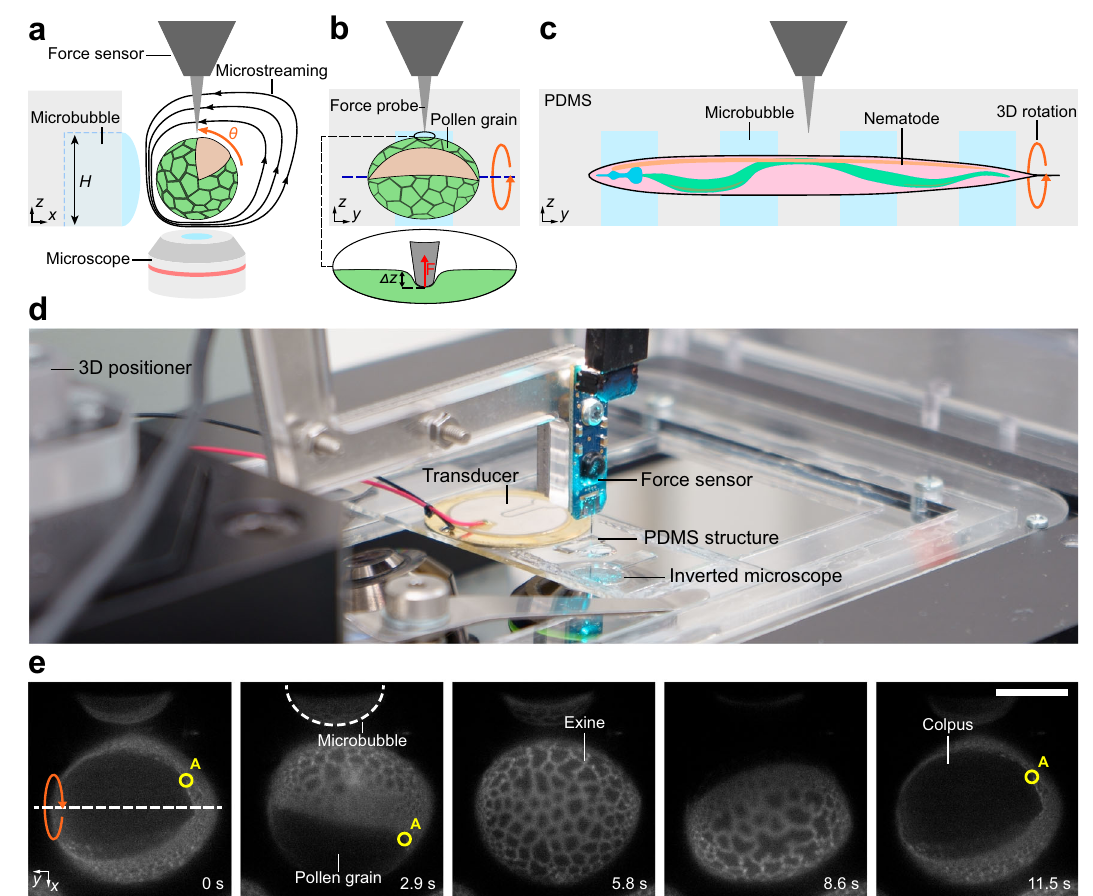
Fig. 1 Setup for acoustic manipulation and micro-indentation. a , b Side and front view schematics describing the 3D characterization of a pollen grain. Acoustic streaming, generated by exciting trapped microbubbles, allows the trapping of pollen grains and their re-orientation with respect to the force sensor. This enables the 3D mechanical characterization of a sample. H denotes the height of the microbubble, θ the rotational angle of the specimen, and x , y , z de fi ne the coordinate system where the force F applied by the sensor in z -direction leads to a displacement Δ z . c A schematic showing the manipulation and indentation of a single C. elegans nematode. By exciting multiple parallel microbubbles, the same design used for pollen grains can be applied to manipulate a nematode. d A photograph of the setup with the manipulation device, consisting of a PDMS structure and a piezoelectric transducer, as well as the force sensor used for mechanical characterization of the specimens. e A slowly rotating auto- fl uorescent pollen grain. Stable rotation of the pollen grain is controlled via acoustic excitation. A denotes a speci fi c location on the pollen grain ’ s surface which is tracked during the rotation of the specimen. Scale bar: 50 µ